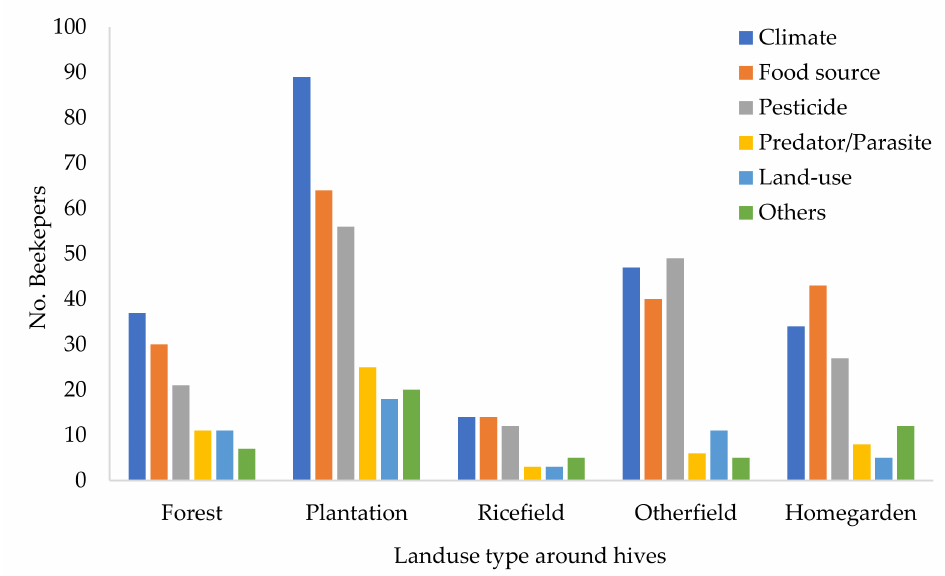
Figure 8. The knowledge of beekeepers on the factors affecting the death of forager bees based on the land-use types where the hives are placed.